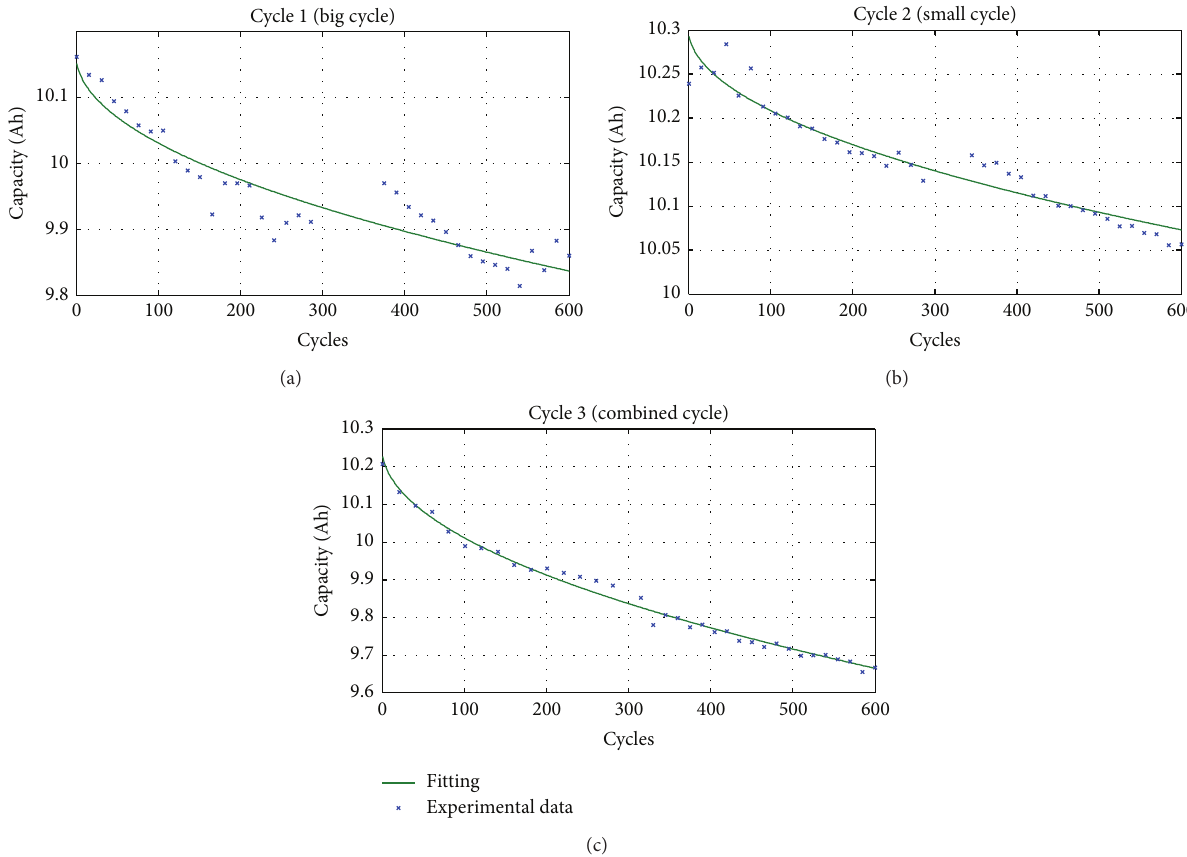
Figure 6: Interpolation of the ageing of the three cells.